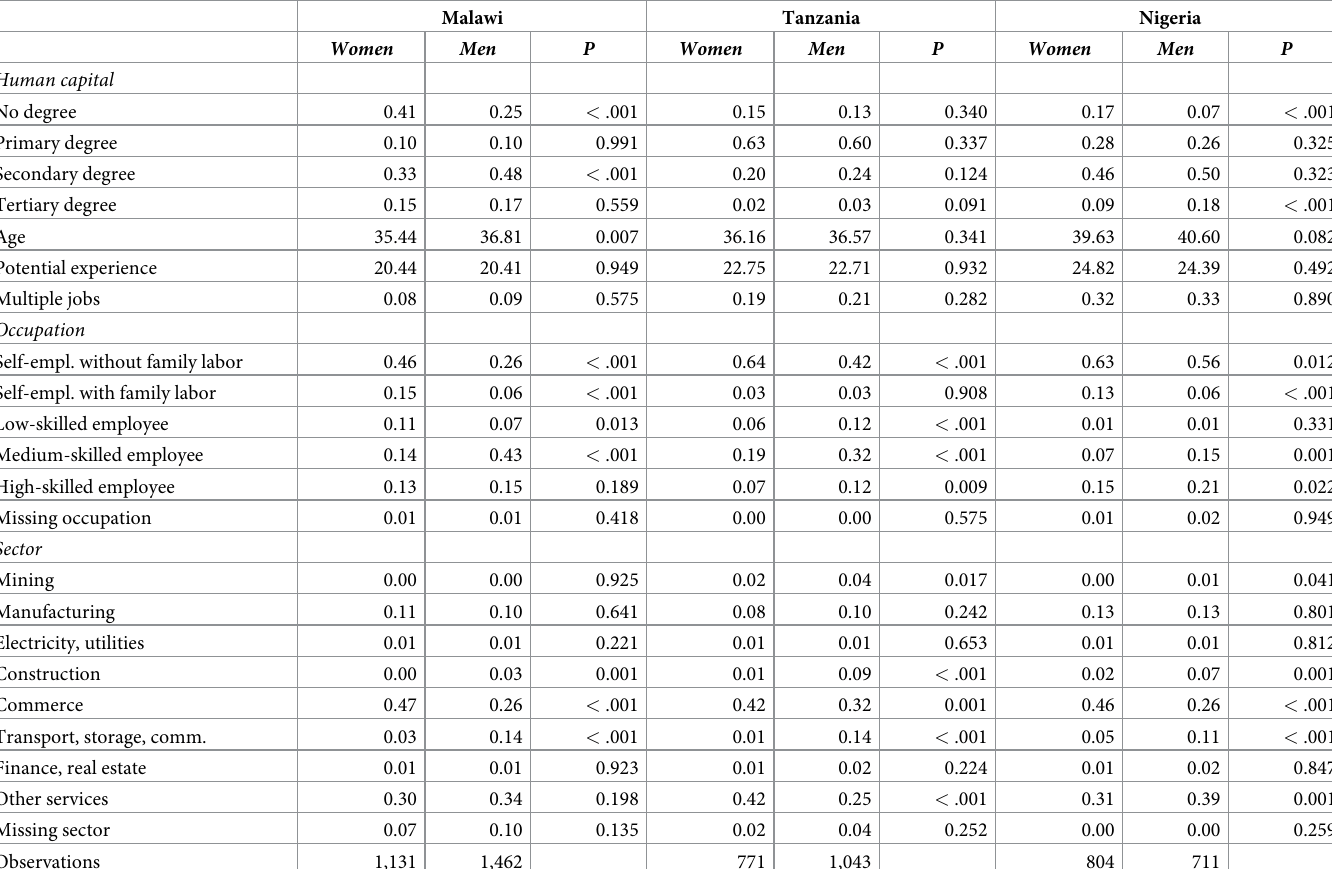
Table 3. Descriptive statistics across gender for non-farm employed people aged 25–55 in urban Malawi, Tanzania and